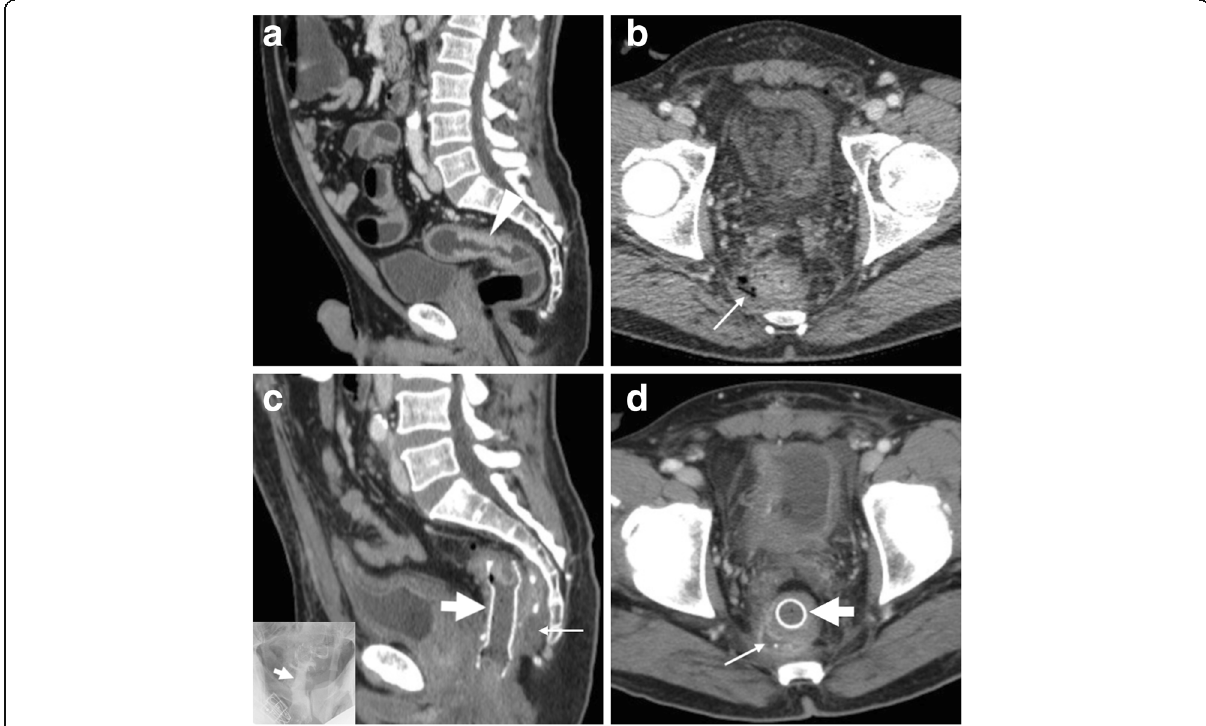
Fig. 12 Successful stent management of postoperative AL. Preoperative water enema CT ( a ) showed stricturing CRC of the rectosigmoid junction (arrowhead). Days after anterior rectal resection with an ileostomy, CT ( b ) was requested because of fever and faecaloid material from drainage tube. Gas bubbles (thin arrow) and mild effusion abutting the site of coloanal anastomosis were consistent with the clinical and endoscopic diagnosis of AL, which was treated by placing a covered SEMS through the anastomosis (inset image in c ). A week later, follow-up CT ( c , d ) showed SEMS (thick arrow) in place, minimal residual perianastomotic fluid collection (thin arrows) and the patient ultimately did